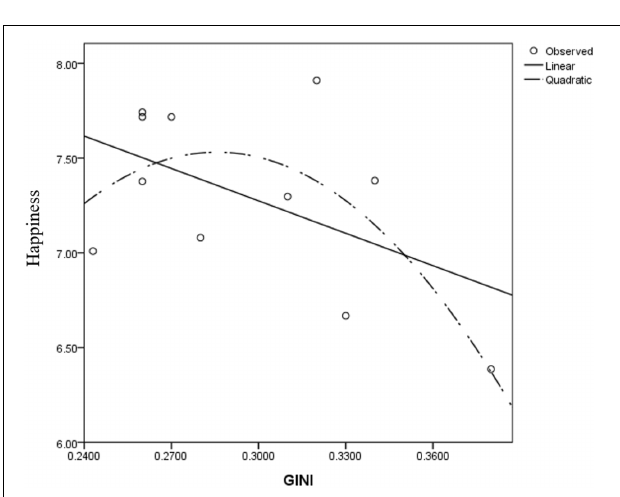
FIGURE 3 | Scatter plot of GINI-happiness for ESS, 2002.